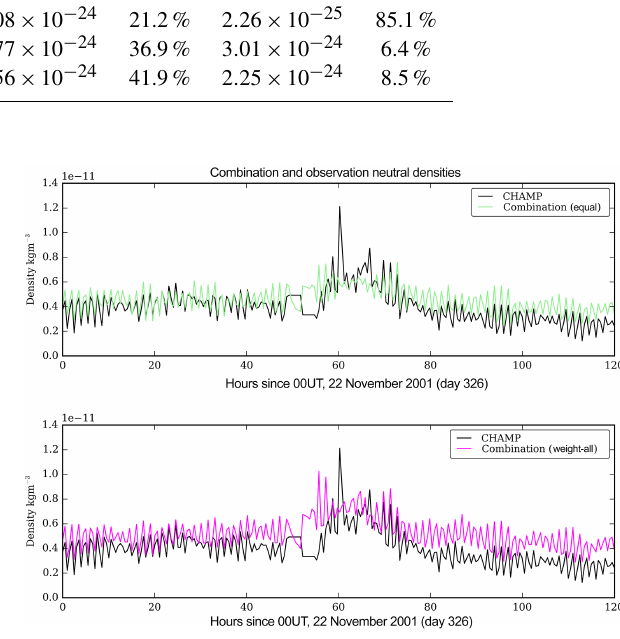
Figure 10. Neutral density values of the two MMEs for the third test scenario, equally weighted and all-times